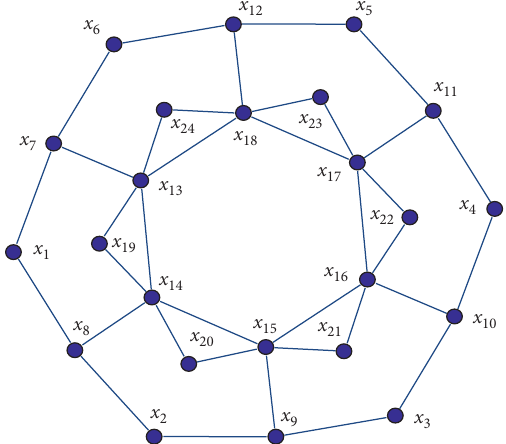
Figure 1: Hexagonal planar graph G with D im